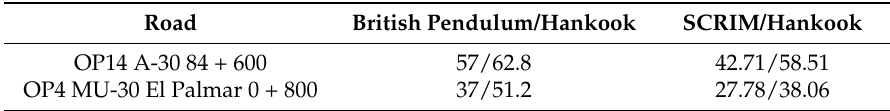
Table 7. Hankook parameter values in the sections A-30 and